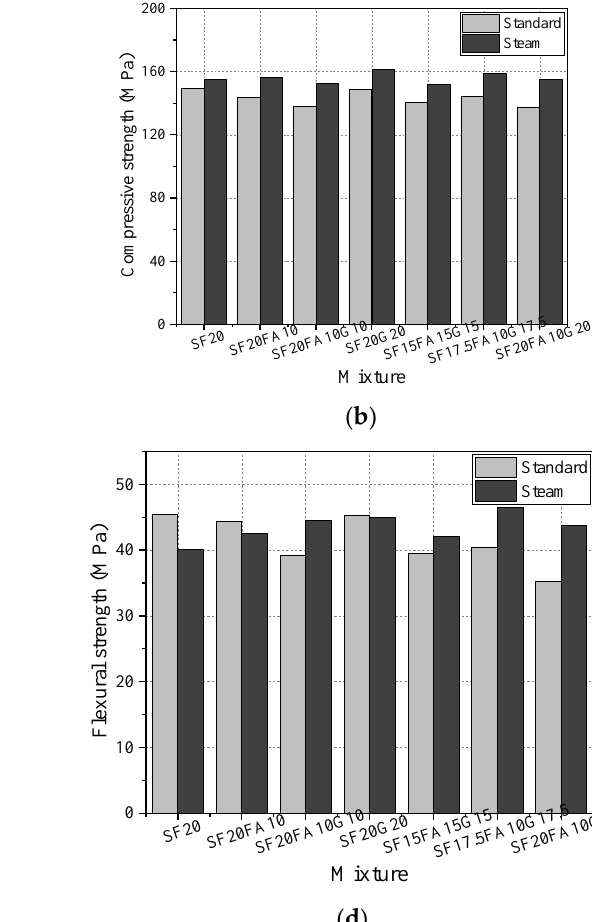
8 of 19 Table 4. Mechanical properties of EUHPC under steam curing. Specimen